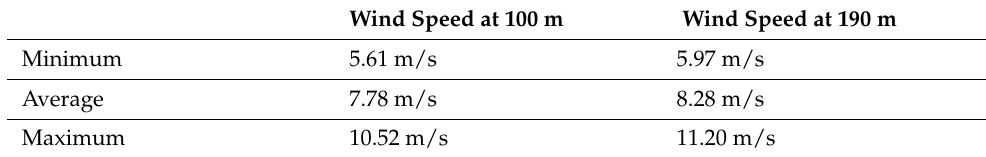
Table 1. Wind Speed at 100 m and 190 m.